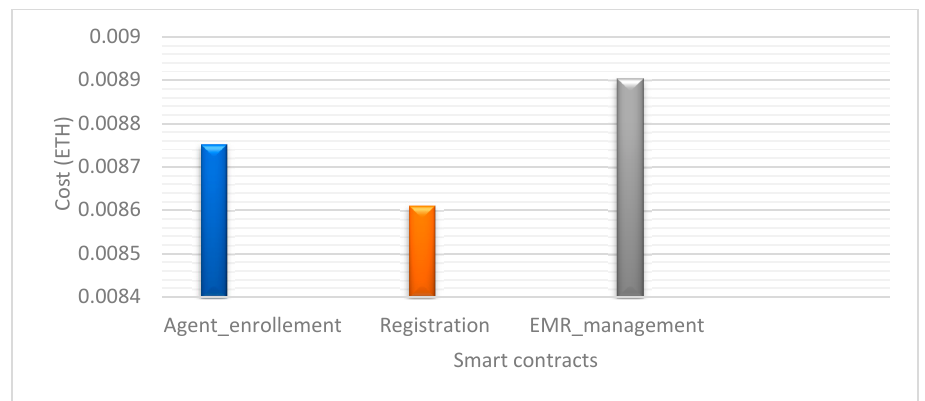
Figure 12. Smart contracts cost.